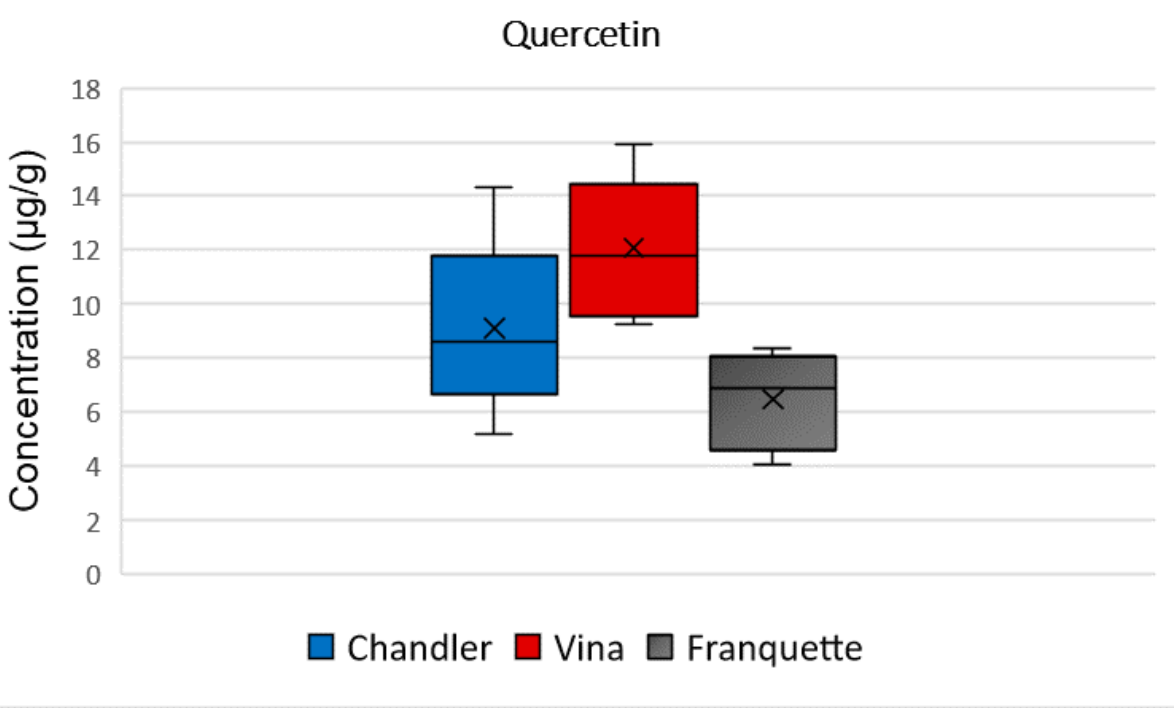
Figure 6. Box and Whisker plot for the concentration of quercetin among walnut septa belonging to the Chandler, Vina, and Franquette varieties.